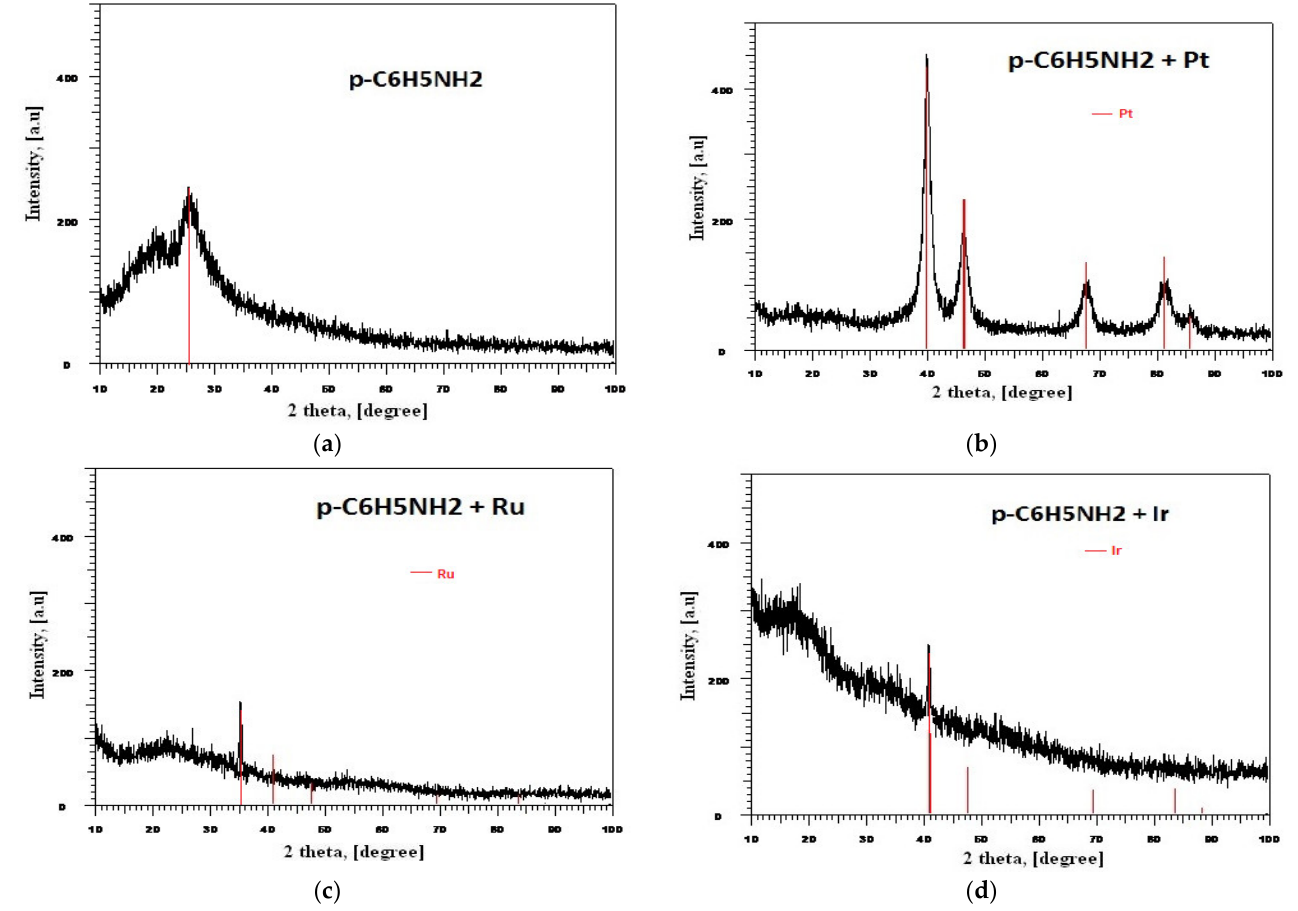
Figure 2. X-Ray plots for ( a ) p-C 6 H 5 NH 2 , ( b ) p-C 6 H 5 NH 2 + Pt, ( c ) p-C 6 H 5 NH 2 + Ru, ( d ) p-C 6 H 5 NH 2 + Ir.